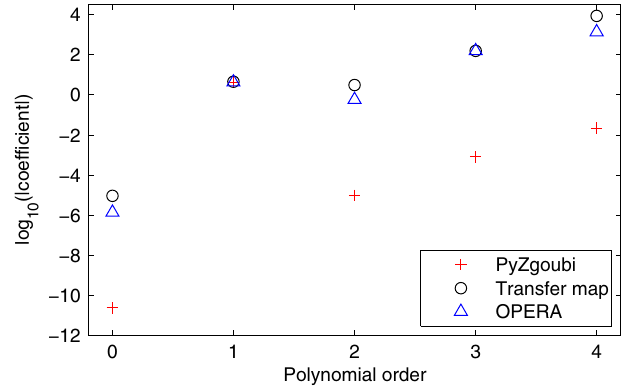
FIG. 11. Value of the coefficients of a polynomial fitted to the horizontal component of the magnetic field as a function of vertical position, for PYZGOUBI (red crosses), transfer map (black circles), and OPERA simulations (blue triangles). Results agree for the first order, corresponding to the quadrupole component of the field. The higher-order coefficients obtained from PYZGOUBI are 5 orders of magnitude smaller than the corresponding co- efficients in the case of the transfer map and OPERA . There is a much smaller discrepancy between the transfer map and the OPERA coefficients. We conclude that transfer map represents more accurately than PYZGOUBI the nonlinearities in the mag- netic field; this can explain the discrepancy in nonlinear dynam- ics observed in Fig.